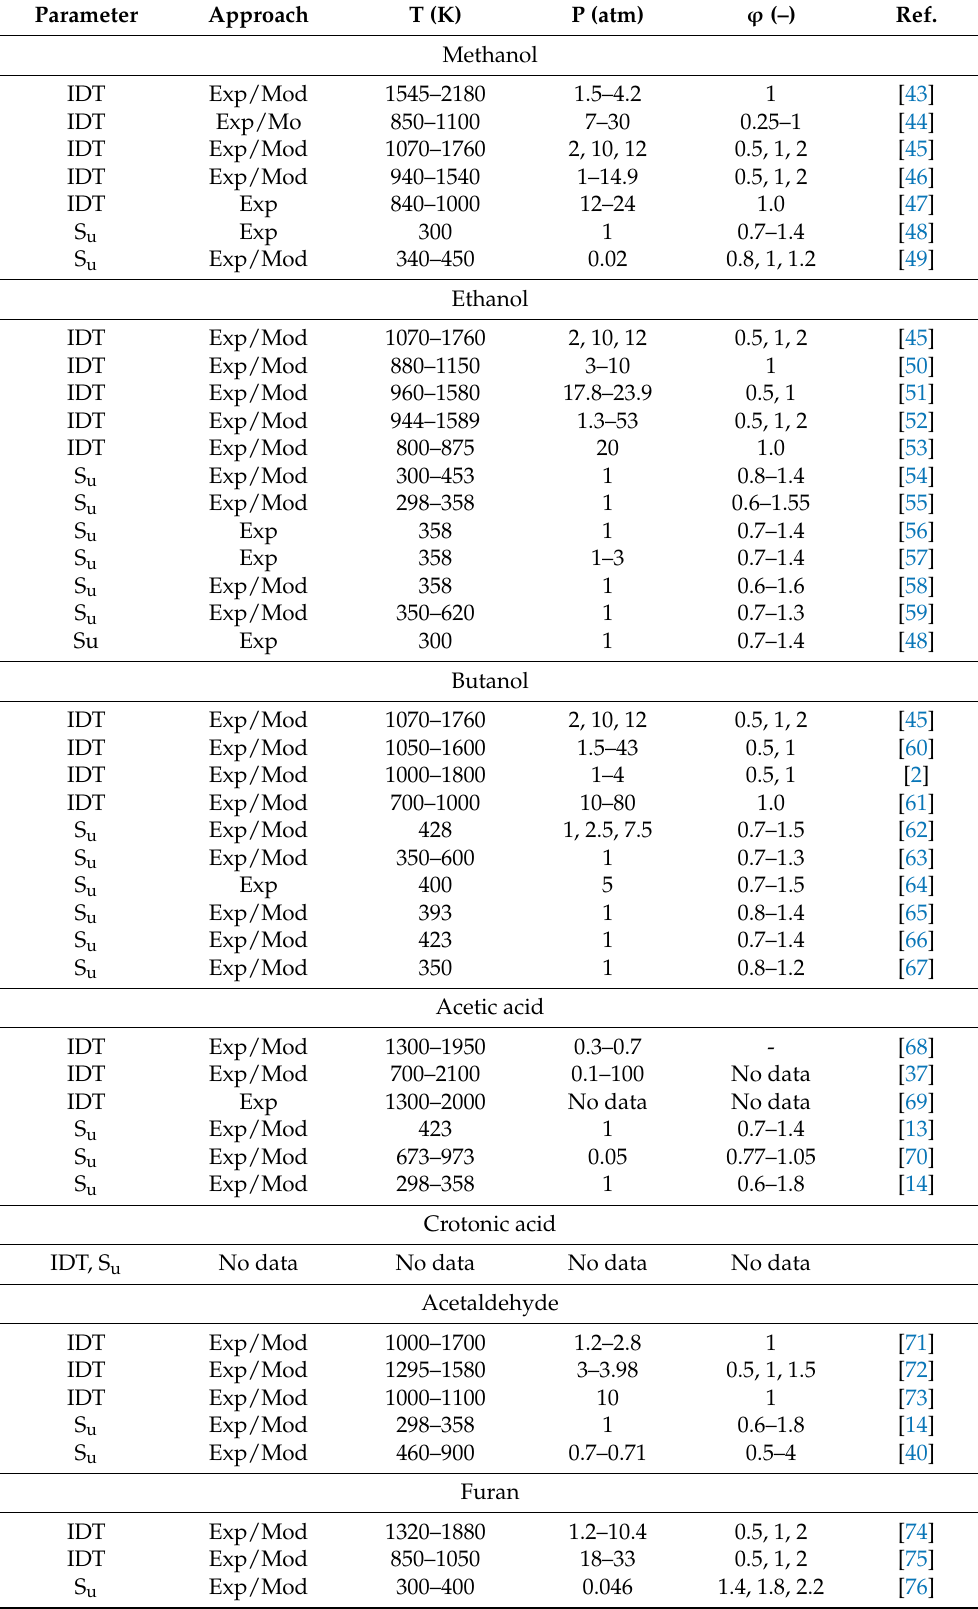
Table 2. Experimental and numerical study data of selected biofuel combustion. ϕ = equivalent ratio; IDT = ignition delay times; S u = laminar burning